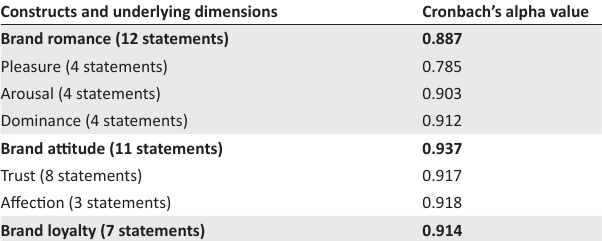
TABLE 4: Cronbach’s alpha values for the measurement sets.